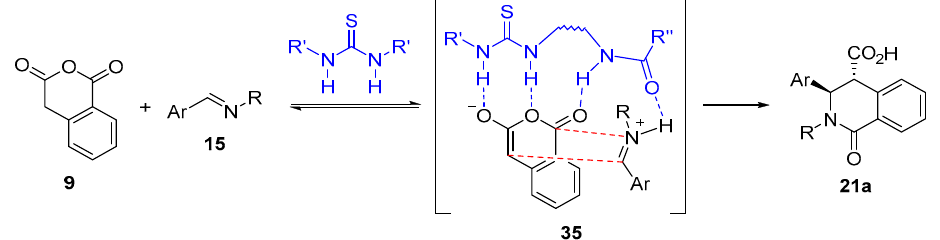
Scheme 13. Representative mechanism of the enantioselective CCR catalysed by general